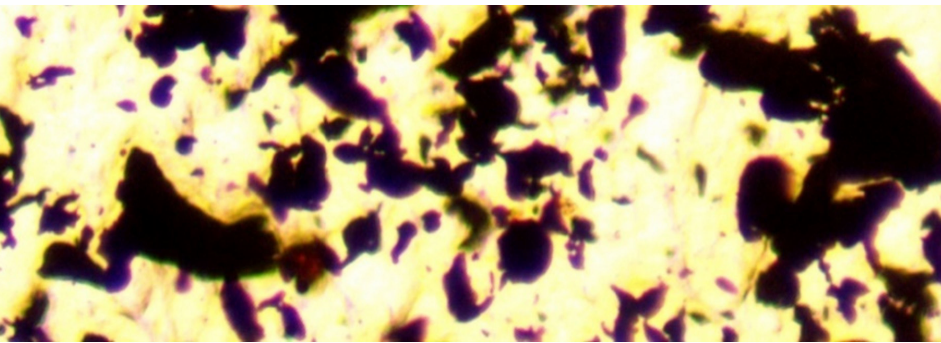
Figure 5. Al 0 particles. Transmitted light, field of view = 0.1 mm (100